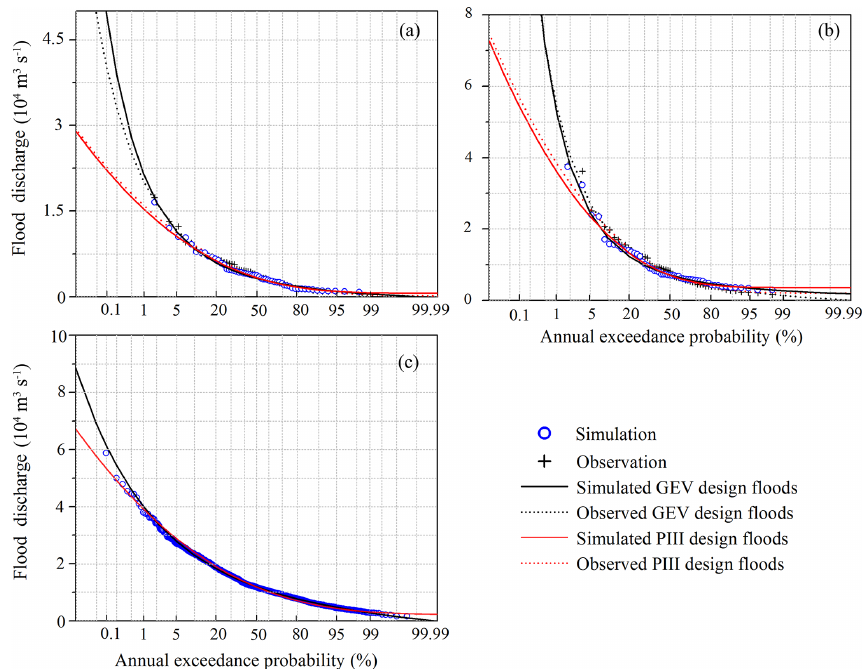
Figure A2. Comparison between the observed and simulated return interval peak discharges in the Ai River and Yalu River based on the GEV and P-III methods. The design floods for the period 1958–2012 in the Ai River (a) and Yalu River (b) and (c) the design floods for the period 1000–2012 in the total Yalu